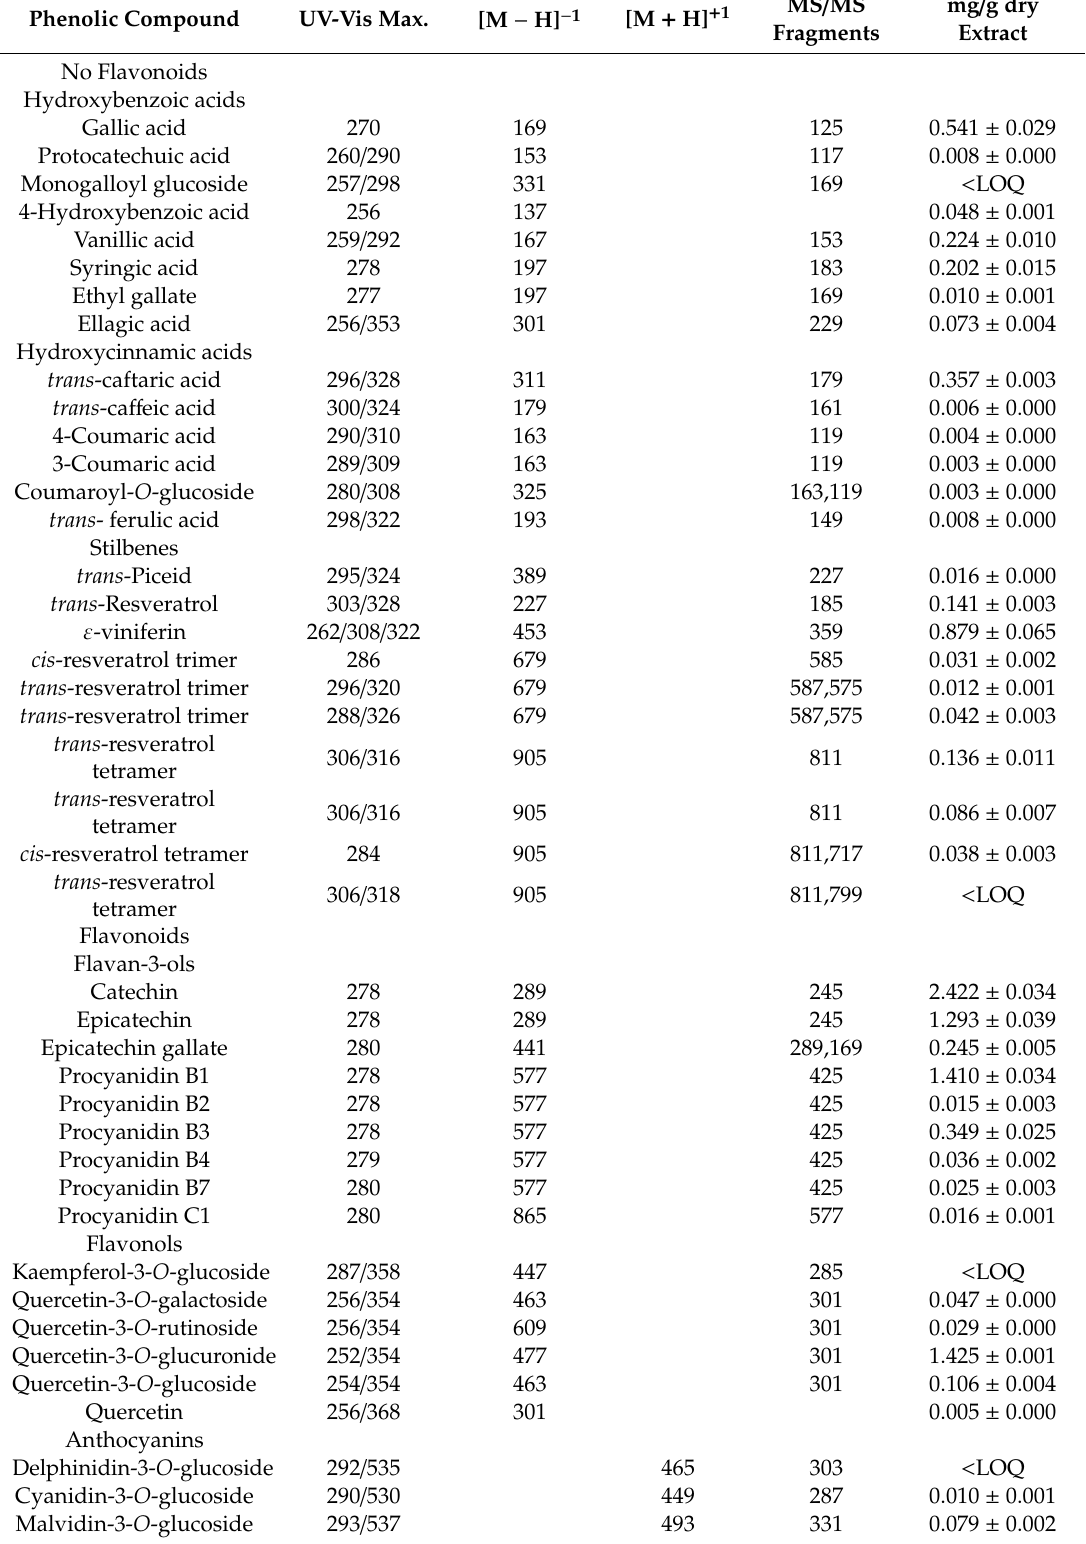
Table 5. HPLC-PAD-ESI-MS phenolic analysis of the optimal grape stem extracts (mg compound / g dry